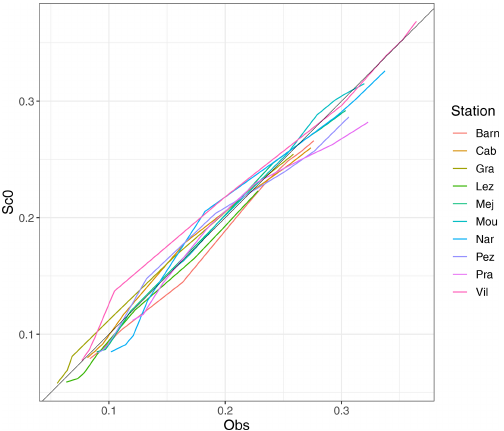
Figure 7. Q–Q plot of simulated (reference scenario) and observed daily soil